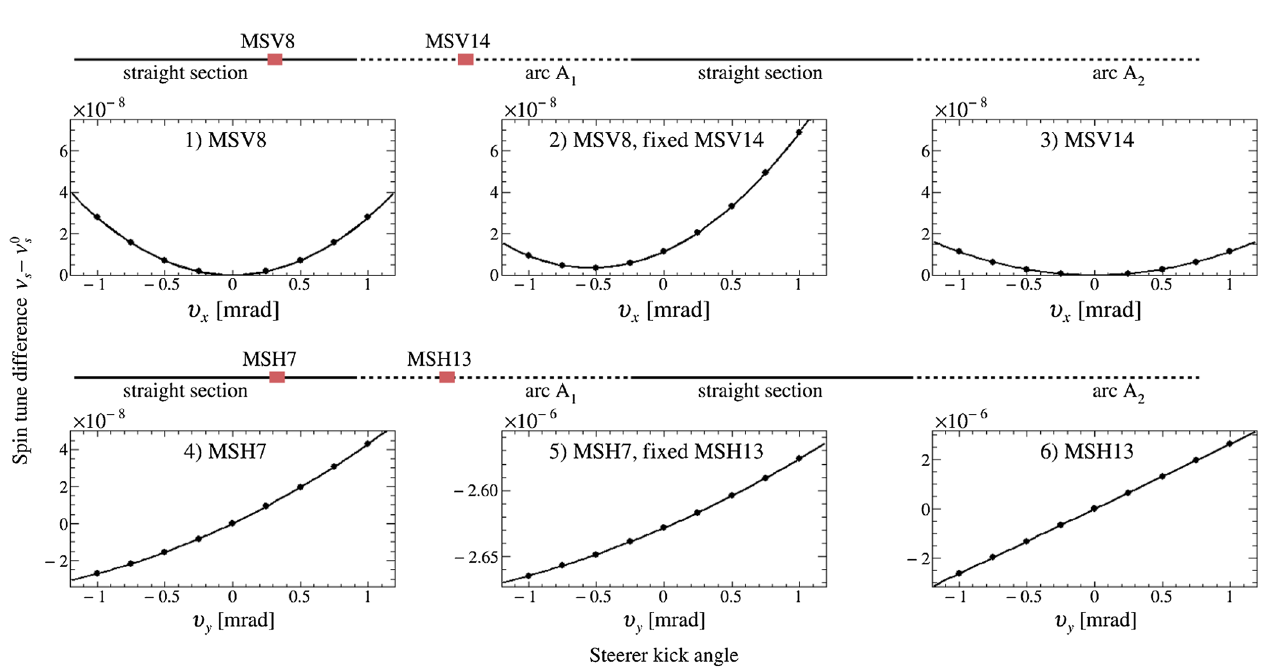
− ν 0 using COSY-I NFINITY for various combinations of beam steerers in arc A 1 and in s s − ν 0 for vertical (horizontal) steerers as function of the steerer kick angle s s